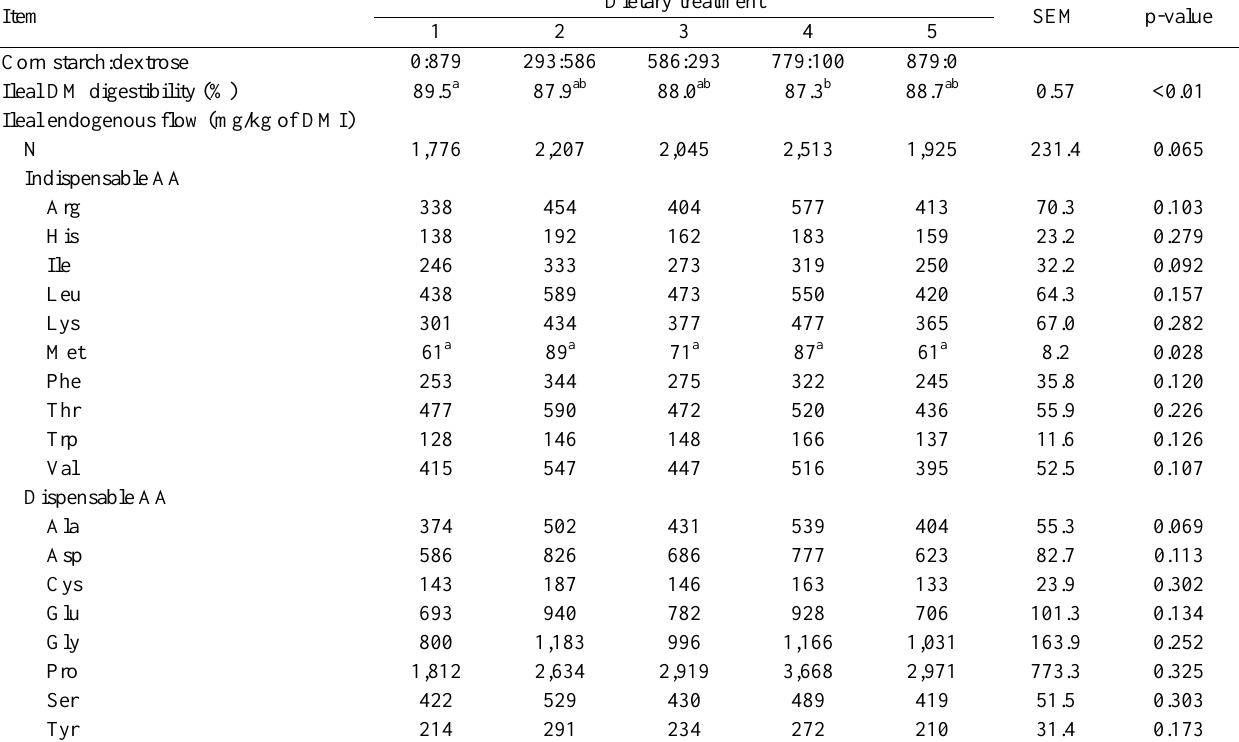
Table 3. Ileal DM digestibility and ileal endogenous N and amino acid flow of pigs fed N-free diets with different proportions of corn starch and dextrose